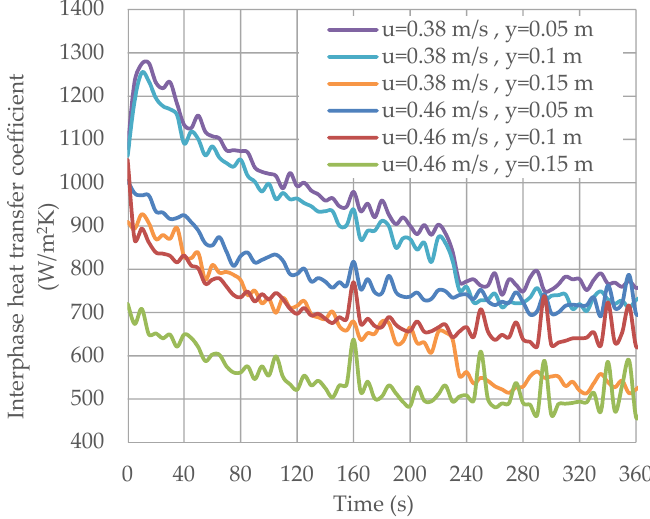
Figure 9. Interphase heat transfer coefficient variation with time at different heights and inlet veloc- ities.